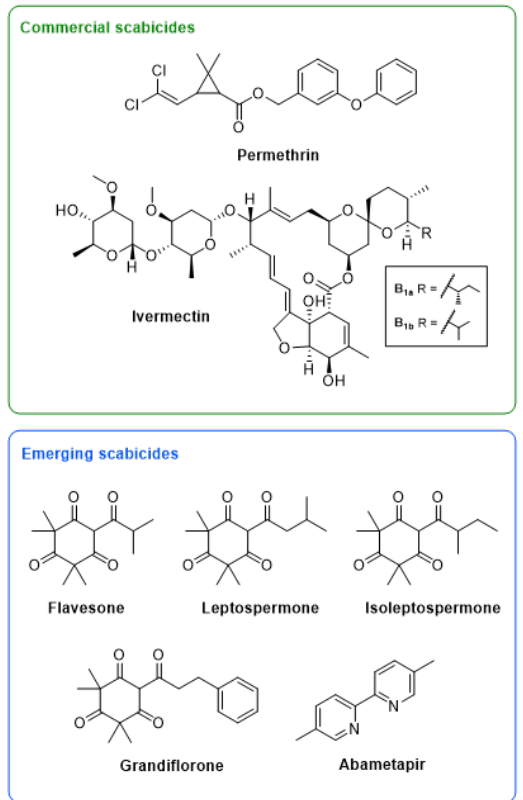
Figure 1. Structures of two commercial scabicides, ivermectin and permethrin, and five emerging scabicides, including a commercial head lice drug, abametapir, and four β -triketones commonly found i n mānuka oil, flavesone, leptospermone, isoleptospermone, and grandiflorone.